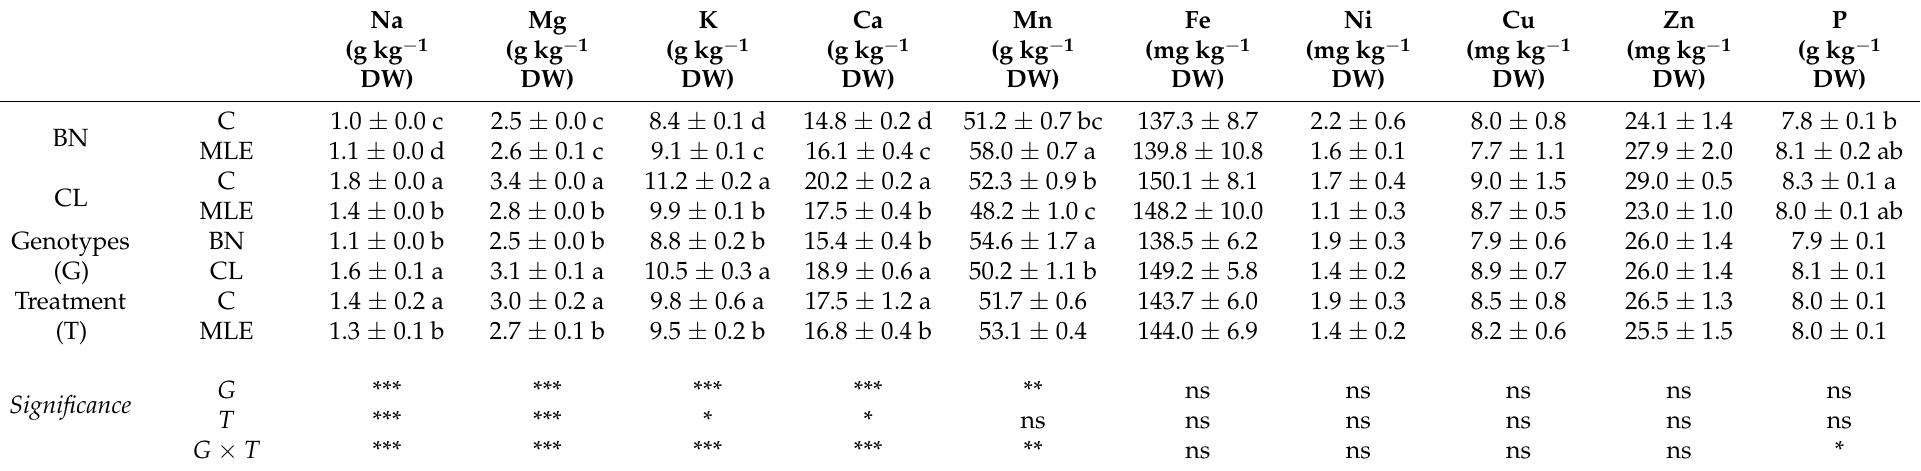
Table 7. Effect of MLE on sodium (Na), magnesium (Mg), potassium (K), calcium (Ca), manganese (Mn), iron (Fe), nickel (Ni), copper (Cu), zinc (Zn) and phosphorus (P) concentrations of CL and BN baby